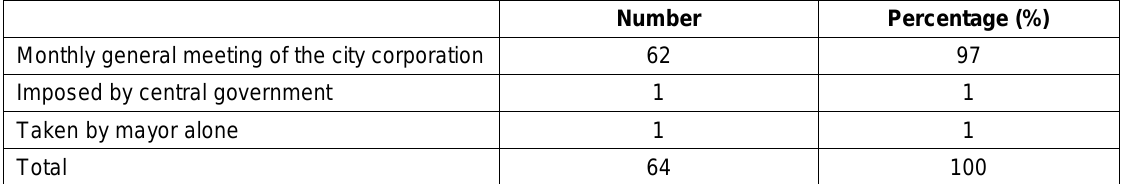
Table 3: Opinions on locus of decision-making (general public)